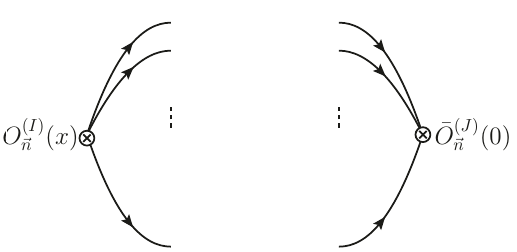
from the I -th node in ~n ¯ from the J -th node in the origin. The umber O ( J ) ~n